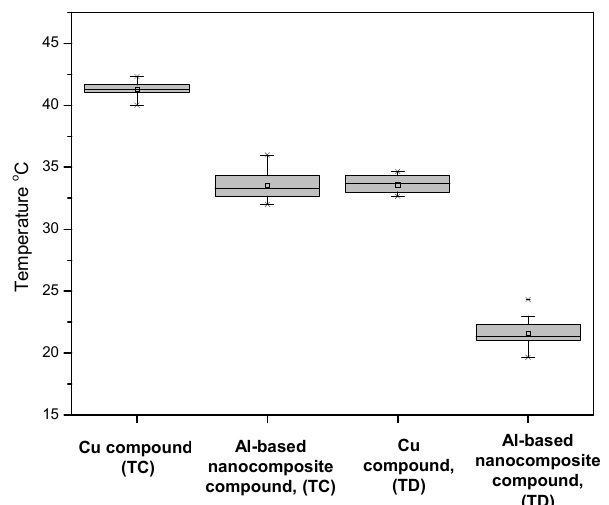
Figure 8. MCCB device temperature operating at 100% rated current monitored at terminals TC and TD of device configuration.